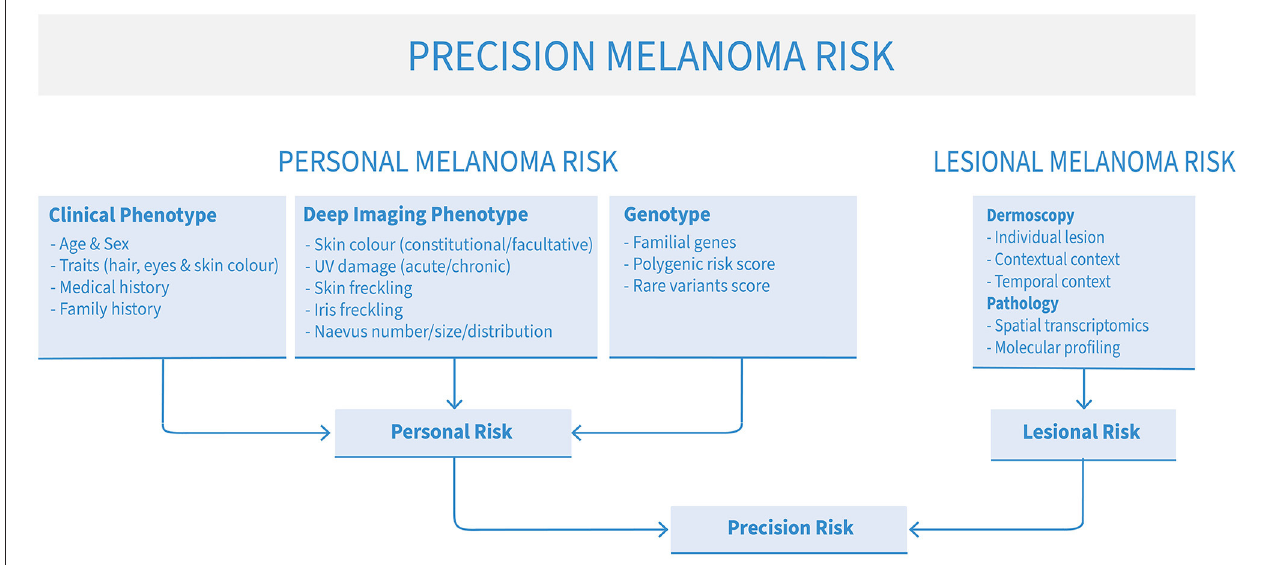
FIGURE 1 | The elements of precision melanoma risk scores for risk stratification and precision prevention of advanced